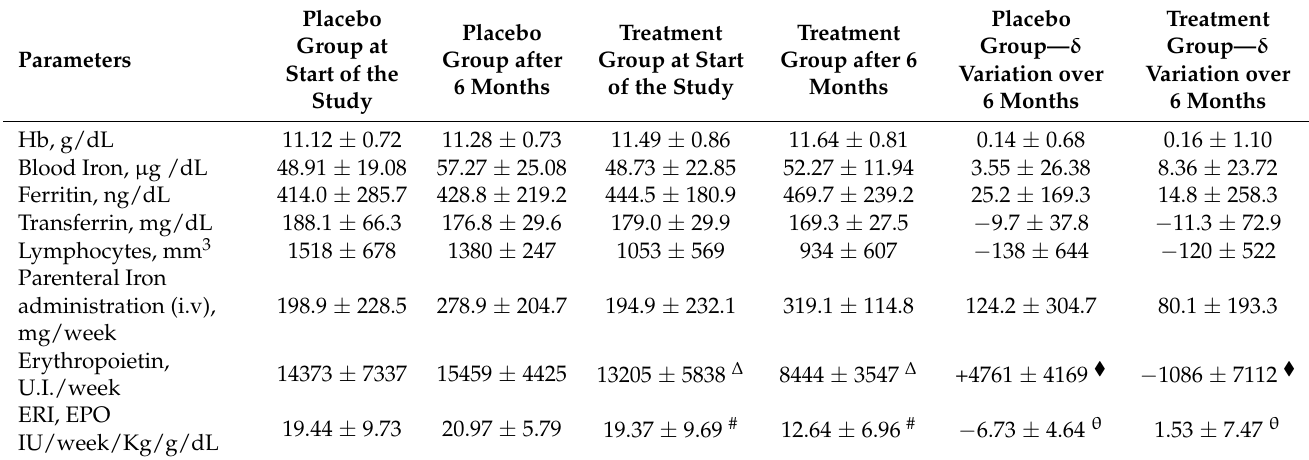
Table 4. Pre-Dialysis Blood Chemistry Analysis in Treatment and Placebo Groups and Differences in Temporal Inter-Study ( δ ) and Intra-Study Group Variations.